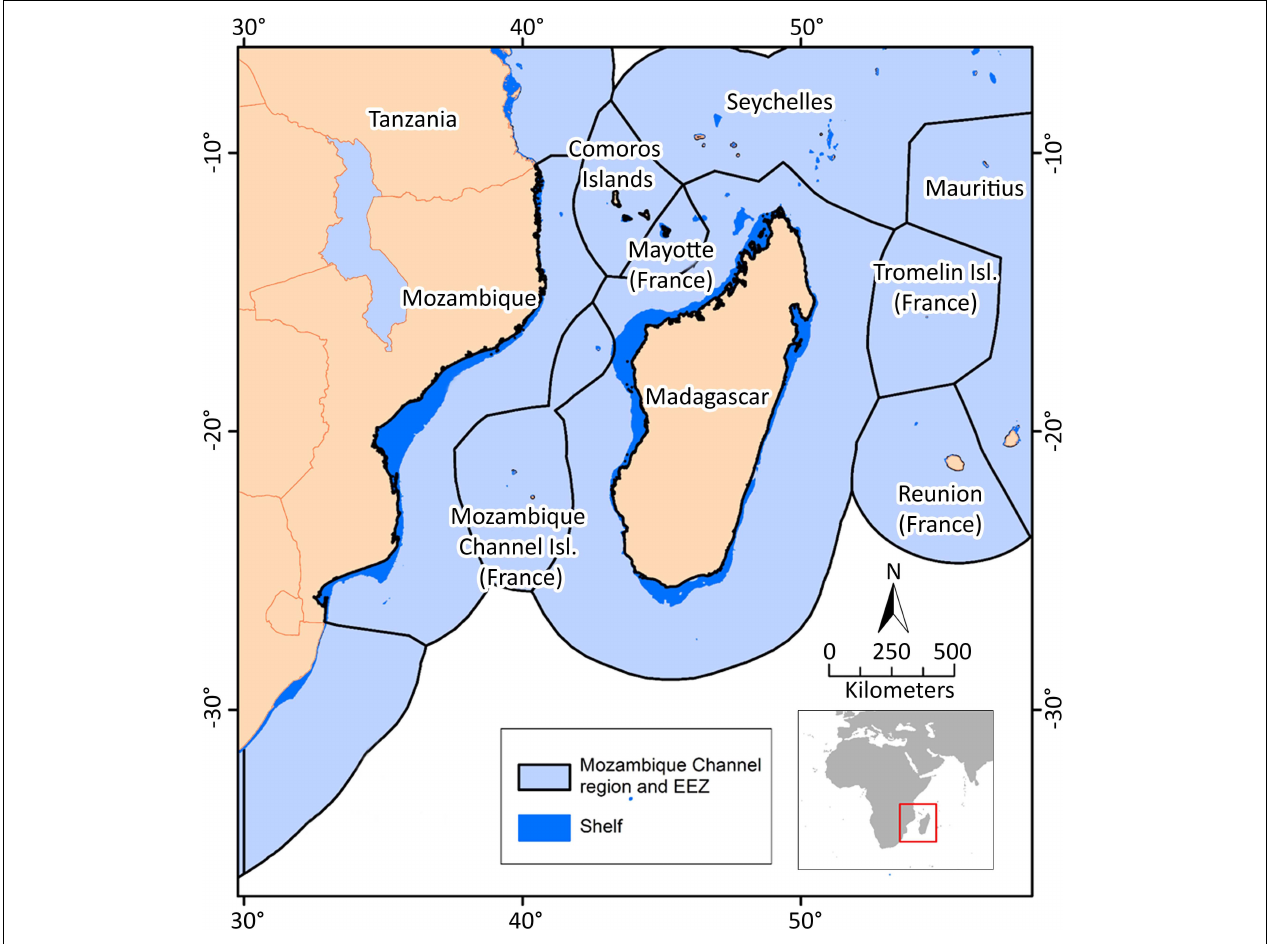
FIGURE 1 | The Mozambique Channel region and the EEZs of the countries or territories considered here: Union of the Comoros, Madagascar, Mayotte, and Mozambique. The uninhabited Mozambique Channel Islands administered by France are indicated as well, but have no domestic, resident small-scale fisheries and thus no resident small-scale effort or